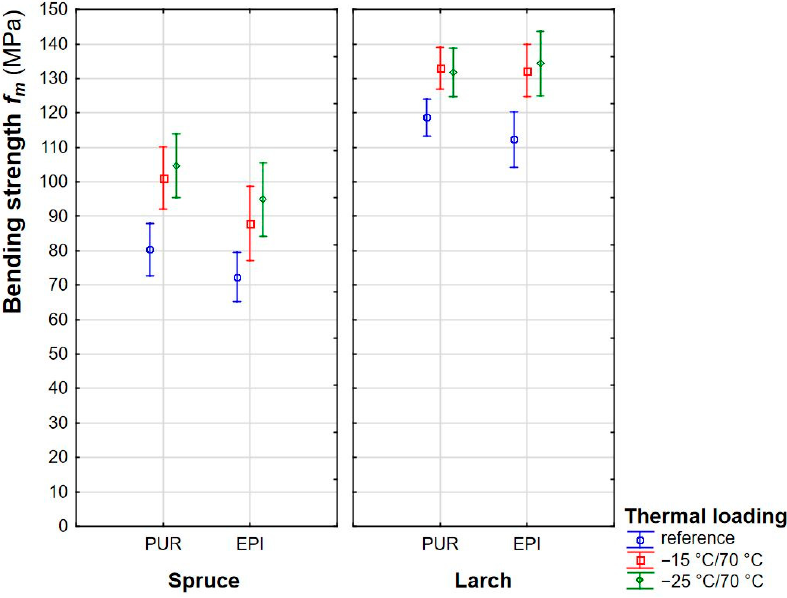
Figure 6. The effect of wood species, adhesive type, and temperature loading on bending strength.